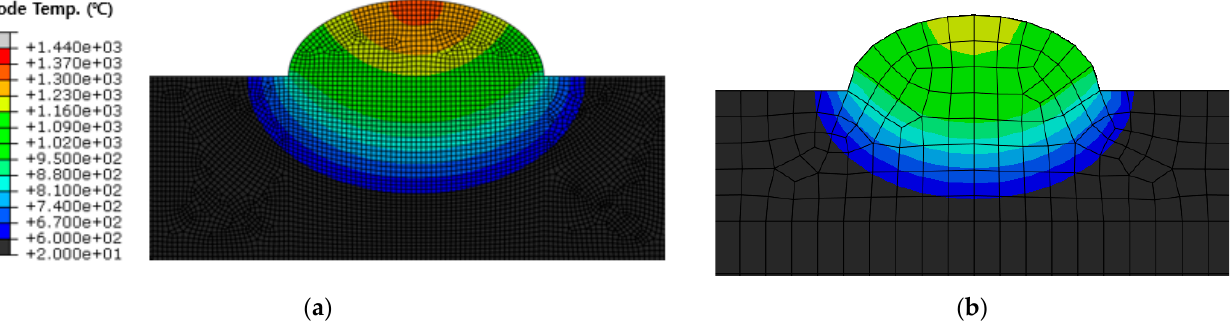
Figure 14. Comparison of temperature distribution 1.6 s after the heat source has passed. ( a ) Simplified model with fine meshes. ( b ) Original dimension model with coarse meshes. Table 9 . Temperature 600 °C line comparison of simplified model and actual model.